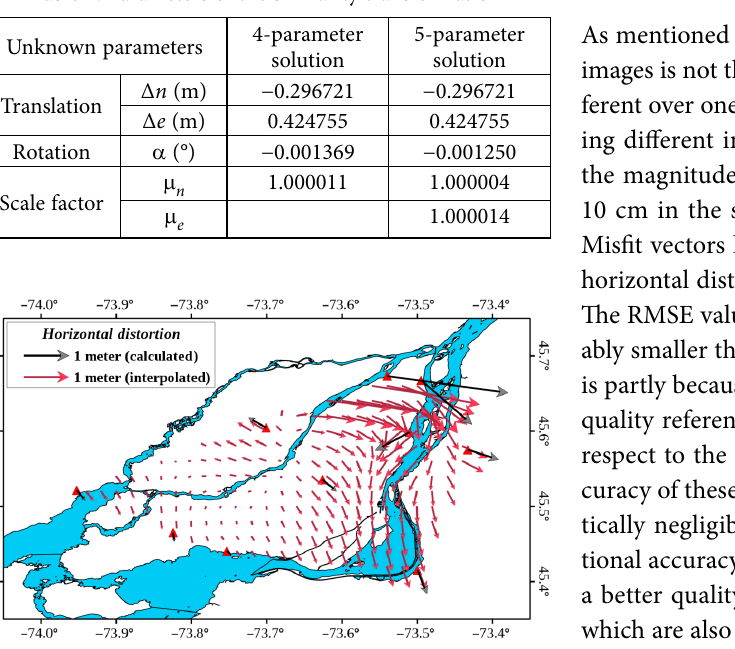
Fig. 3. Representation of interpolated misfit vectors showing a continuous deformation and a very well fit to local